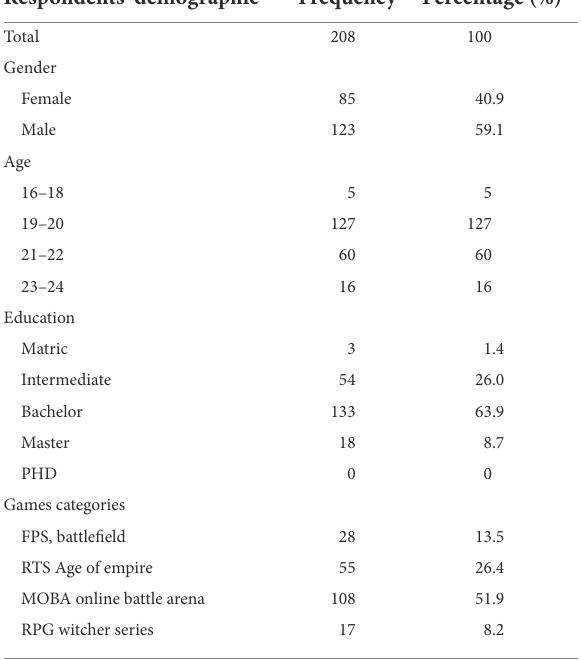
TABLE 1 Overview of respondents’